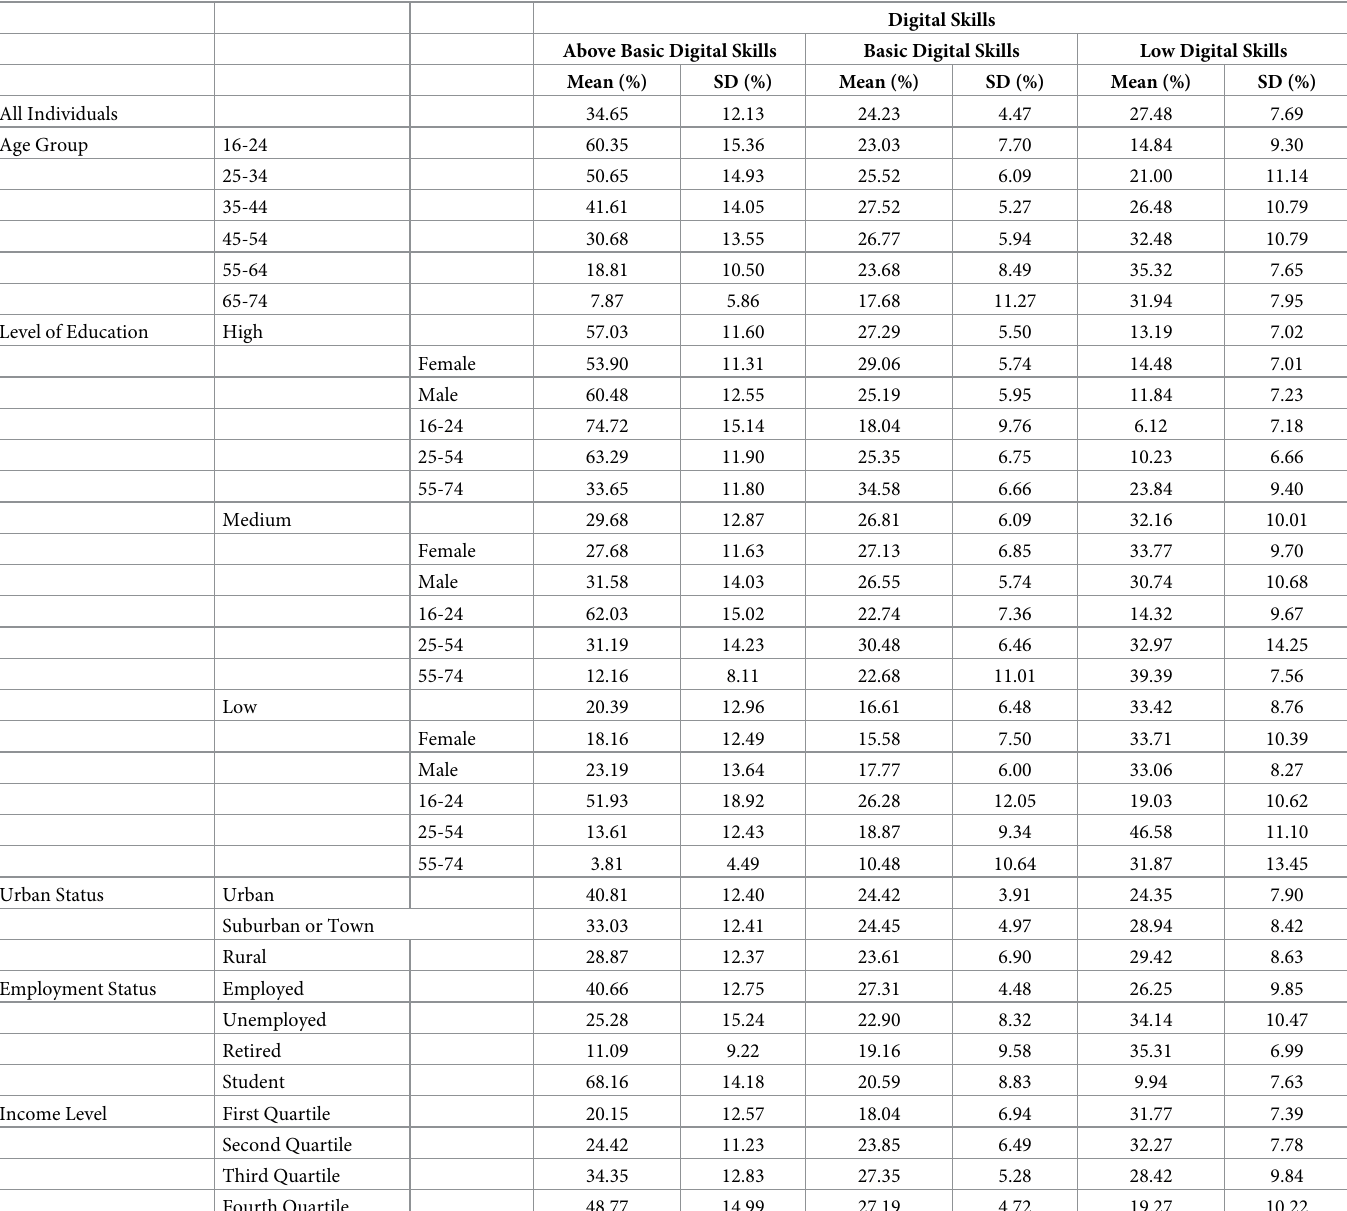
Table 1. Descriptive